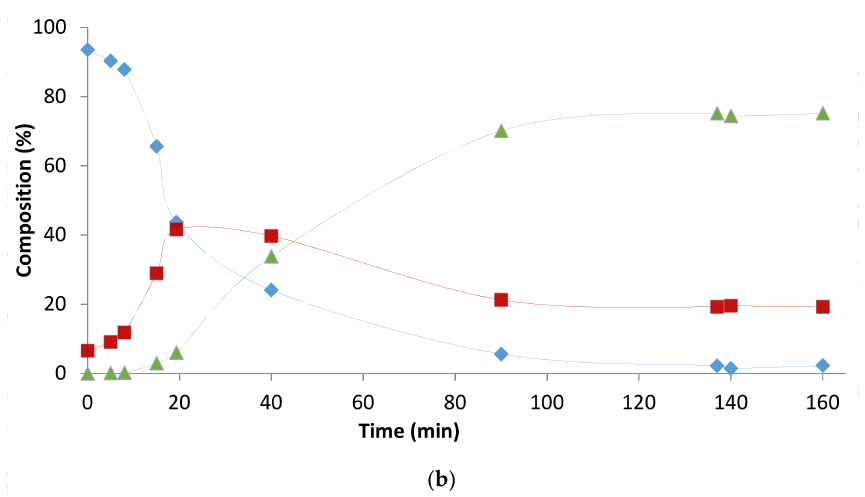
Figure 2. Differences in composition profile as a function of time between the Rh-biphephos system in toluene: ( a ) at [ 1 ] 0 /[Rh] = 20,000; ( b ) at [ 1 ] 0 /[Rh] = 3000; ( (cid:7) 1 , (cid:4) 1- int -x , (cid:78) 2 + 3 ).